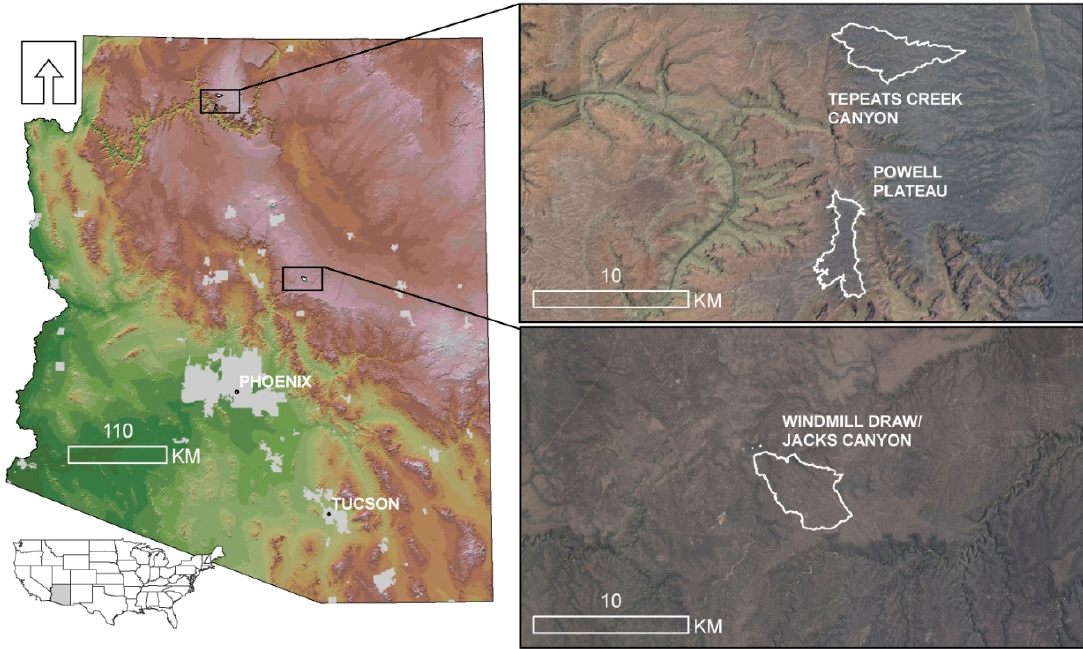
Figure 1. Map of study landscapes in northern Arizona, USA. Powell Plateau and Tepeats Creek on the North Rim of the Grand Canyon, and Windmill Draw/ Jacks Canyon on the Mogollon Rim.